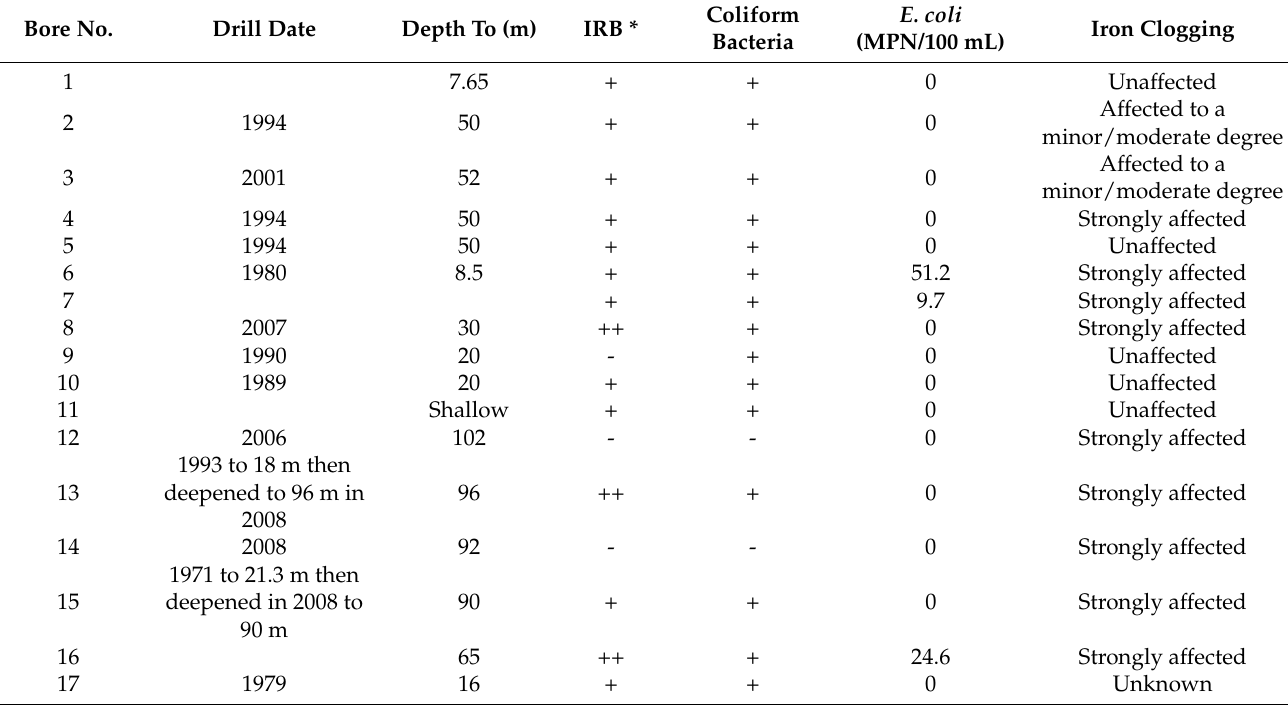
Table A2. Microbial analysis of sampled bores and the iron clogging status. All samples (expect bore number 16 and 24 were sampled after purging. Bore number 16 and 24 were sampled without purging). Bore